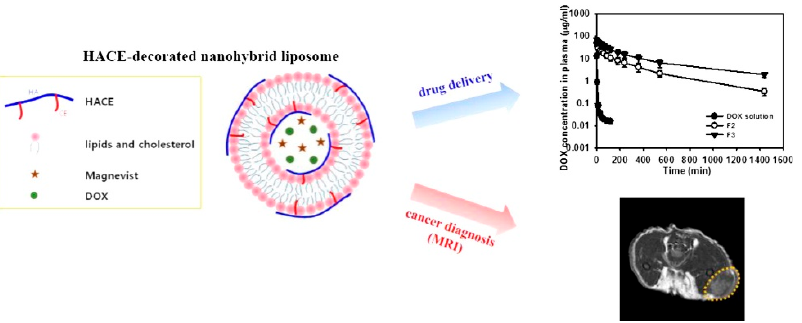
Figure 4. Self-assembled HA-CE nanoparticles for cancer imaging and DOX delivery. Reprinted with permission from Ref. [82]. 2013, Elsevier B.V.